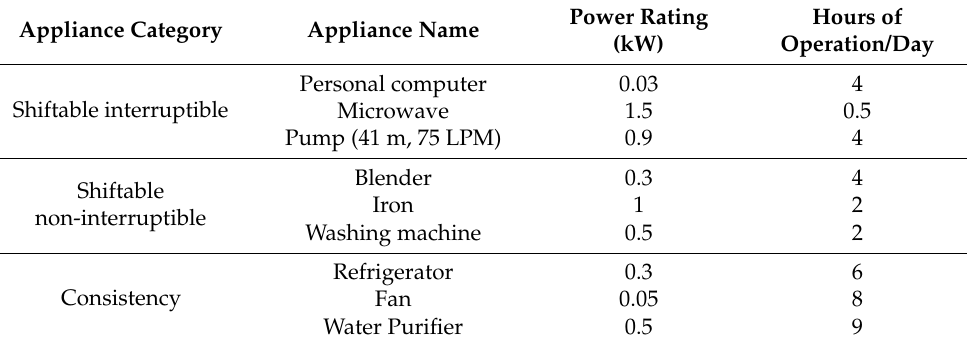
Table 2. Household appliances categories, ratings and hours of operation [23,44].